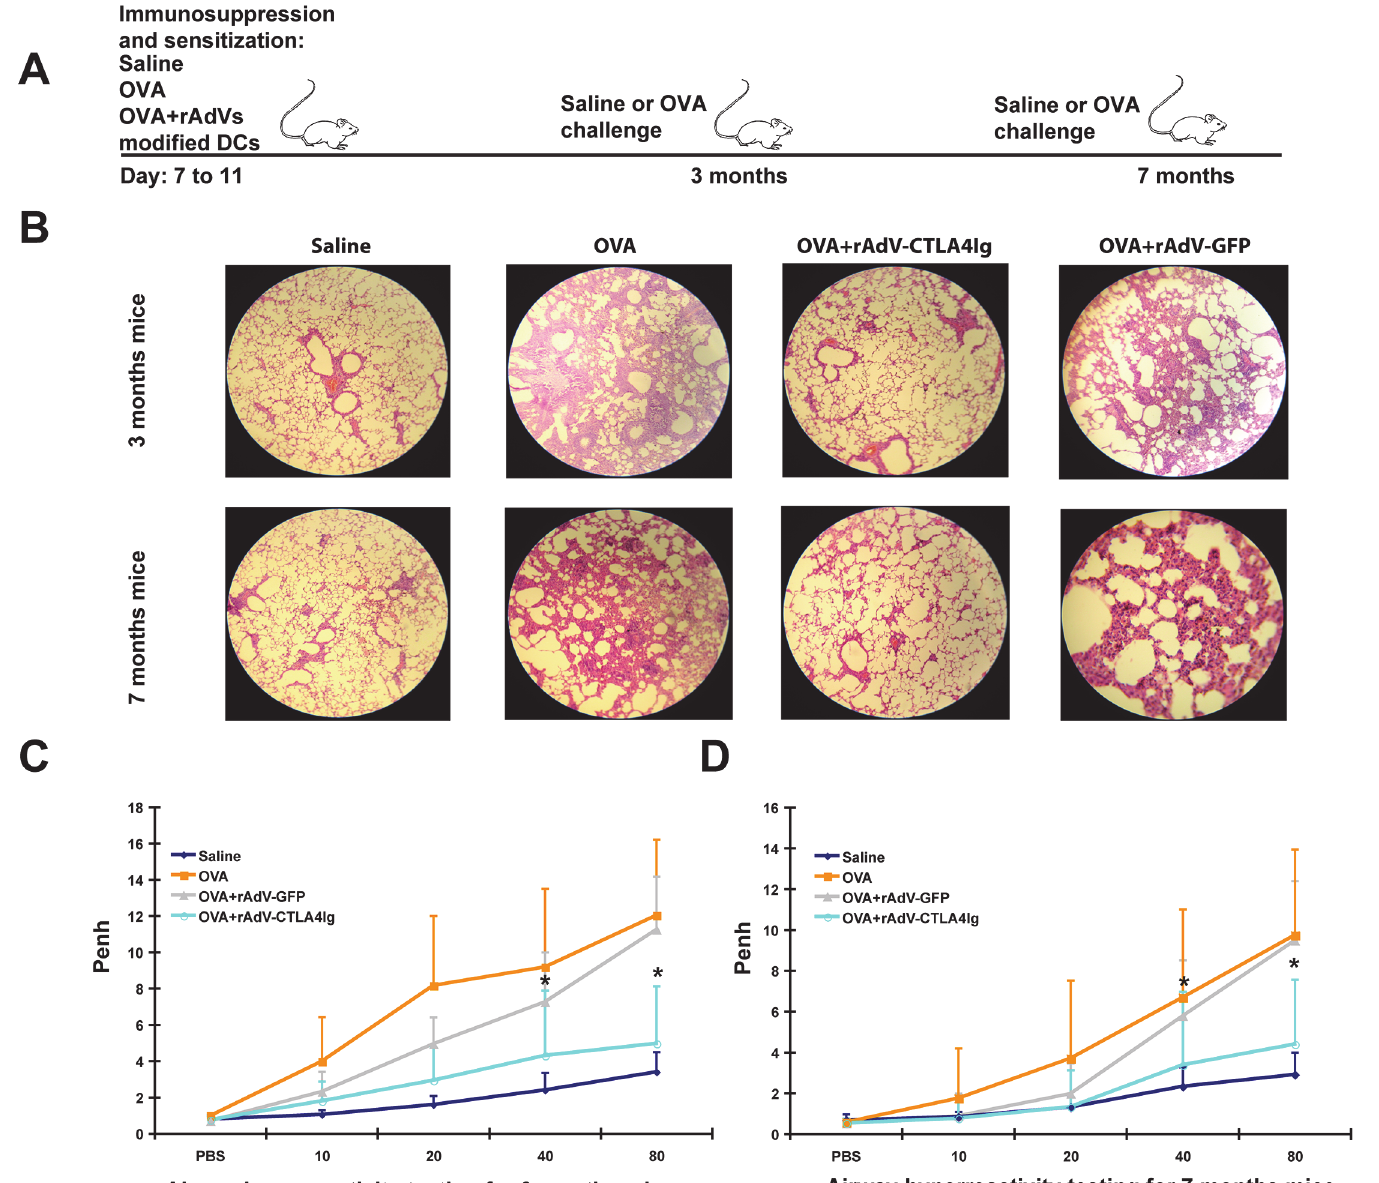
Fig 2. Persistence of immune tolerance to asthma antigens in the adult stage. Saline and OVA represented mice treated, sensitized and challenged by saline and OVA respectively. OVA+rAdV-CTLA4Ig and OVA+rAdV-GFP represented mice treated with OVA+rAdV-CTLA4Ig and OVA+rAdV-GFP in the neonatal period sensitized and challenged by OVA at 3 and 7 months old. Each group contains 10 mice. A, regimen of sensitization, challenge, and treatment. B, representative histopathological characteristics of mice lung: upper, lungs of 3-month-old mice; lower, lungs of 7-month-old mice. C, airway reactivity testing in 3-month-old mice. * indicates significantly low airway reactivity of OVA+rAdV-CTLA4Ig treated mice versus the asthma mice (OVA group). D. airway reactivity testing in 7-month-old mice. * indicates significantly low airway reactivity of OVA+rAdV-CTLA4Ig treated mice versus the asthma mice (OVA